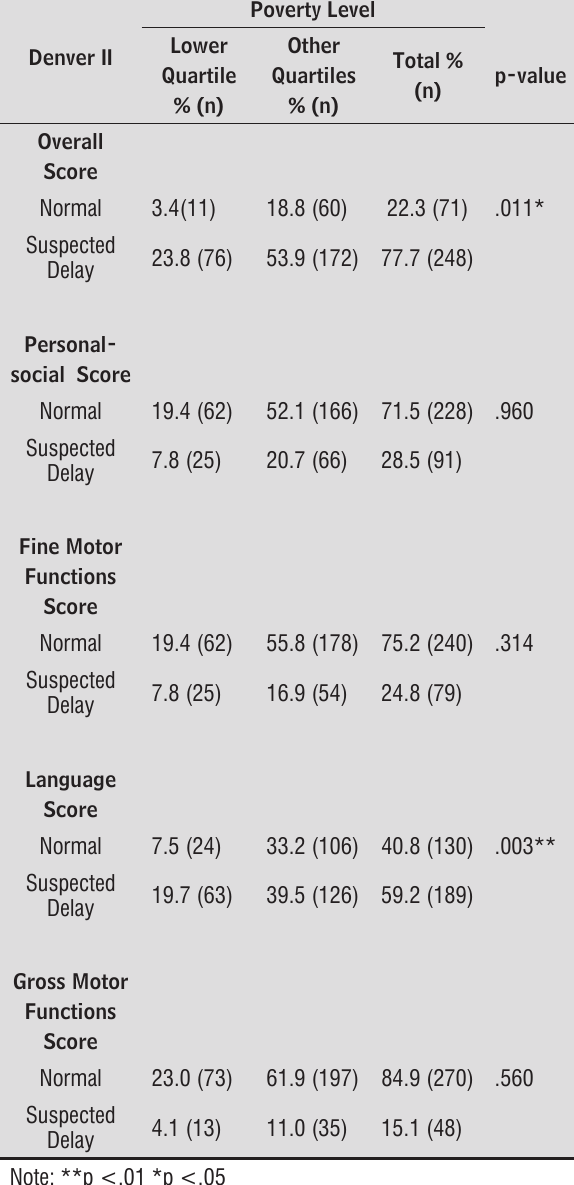
Table 3 - Poverty Level Score in relation to the